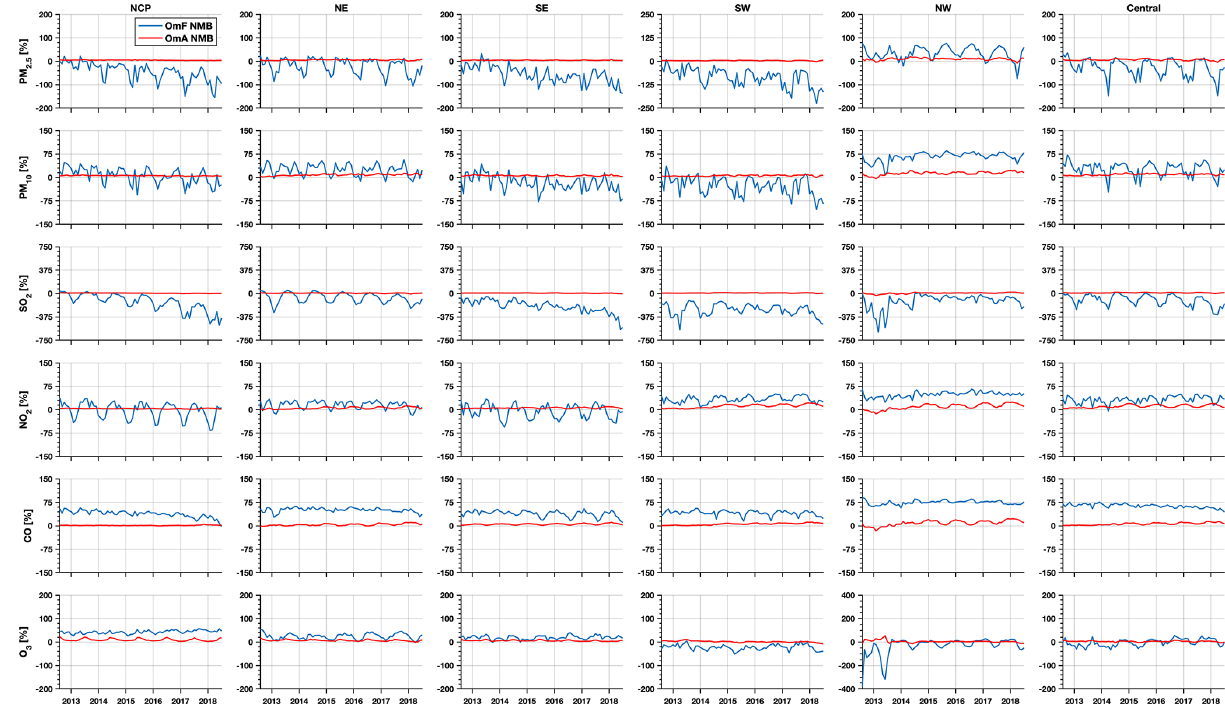
Figure C1. Time series of monthly mean OmF and OmA normalized mean bias in different regions of China for different species.